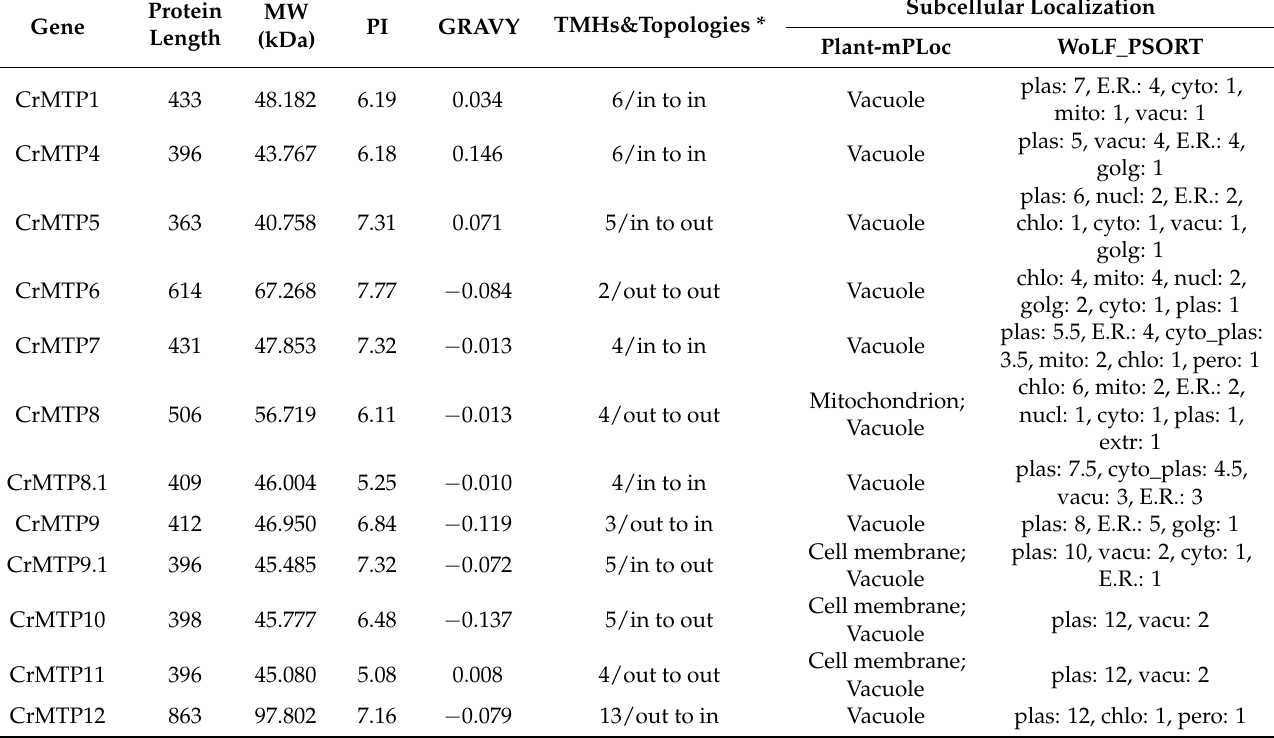
Table 1. Identified CrMTPs of Canavalia rosea (Sw.) DC. and their molecular characteristics.